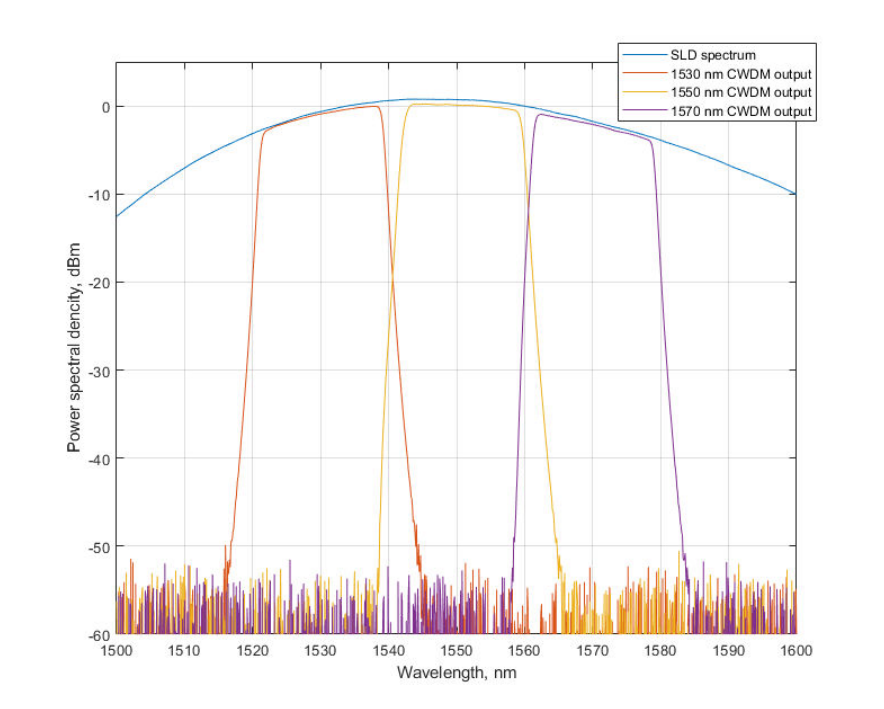
Figure 7. SLD transmission spectra of CWDM modules.